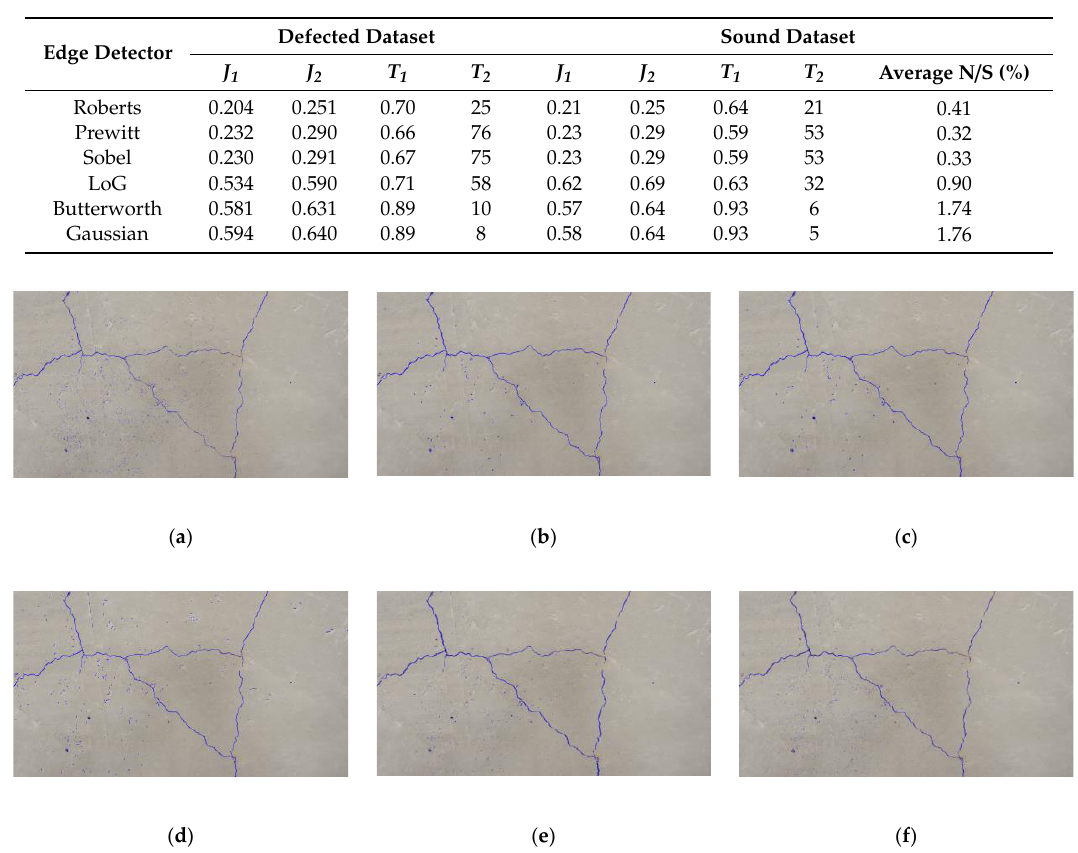
Table 2. The average range and threshold value for each method in defected and sound datasets.